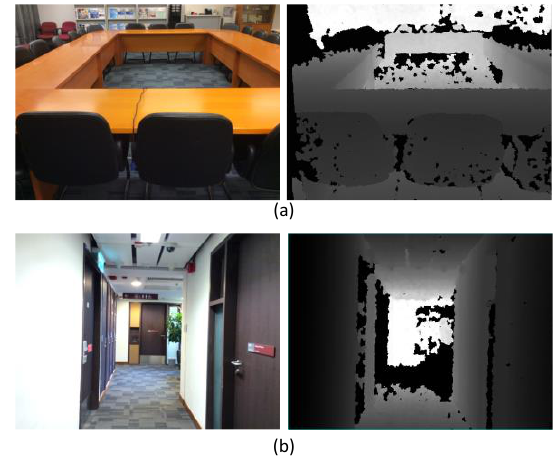
Table 1. Calibration results of IR camera and RGB camera For the first dataset, a sample registered frame with the RGB image (left) and depth image (right) is shown in Figure 5(a). The white part in the depth image indicates that no depth value is measured due to the distance limitation or the type of surface material. This dataset contains 244 registered frames collected in a big meeting room. Because of the lack of shape structure, the IR view range is only set at 4.98*2.16*1.37 m to ensure uninterrupted tracking. The second dataset was collected along a corridor. The whole length of the trajectory was about 26.5 m. It contains 305 registered frames. The two images in Figure 5(b) show the RGB frame (left) and depth frame (right).